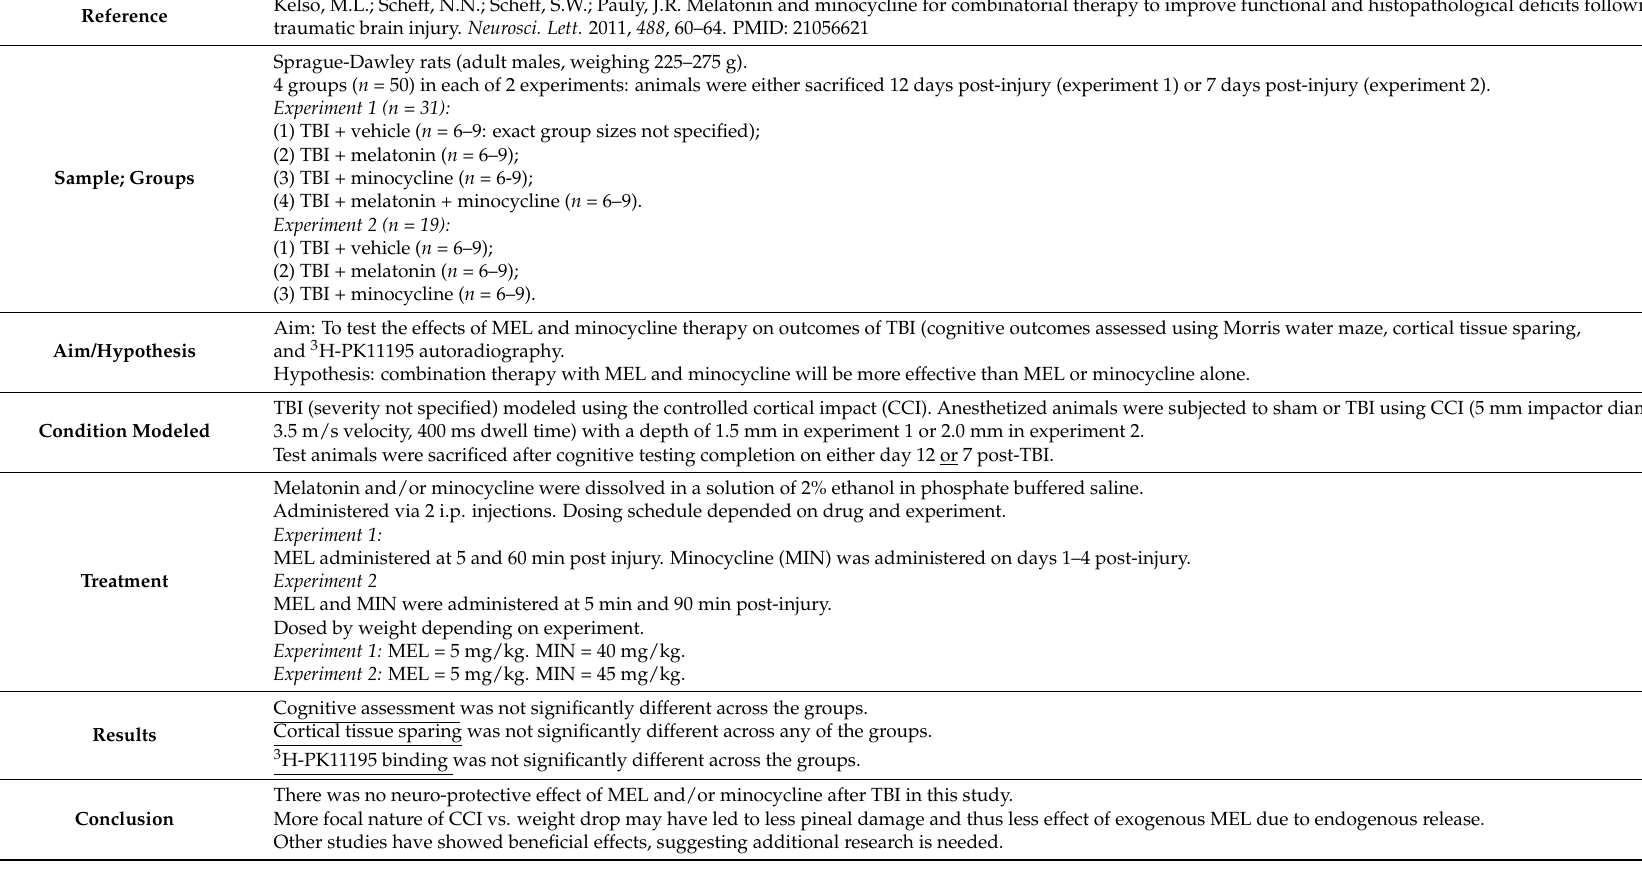
Table A11. Kelso et al. (2011) Study